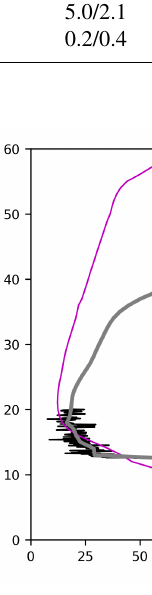
Figure 7. The “extended” AirCore CO profile together with the TC- CON a priori profile, original AirCore and surface in situ measure- ments on 15 July 2014 at